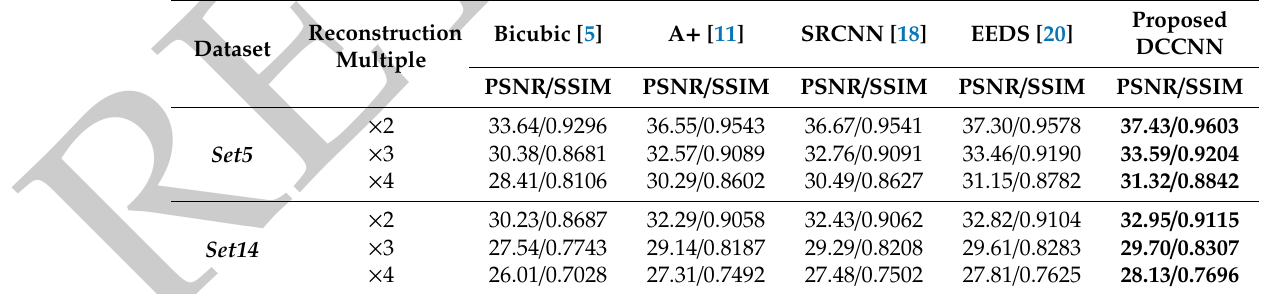
Table 1. Average Peak Signal-to-Noise Ratio (PSNR) and Structural Similarity Index (SSIM) at di ff erent reconstruction scales on Set5 and Set14